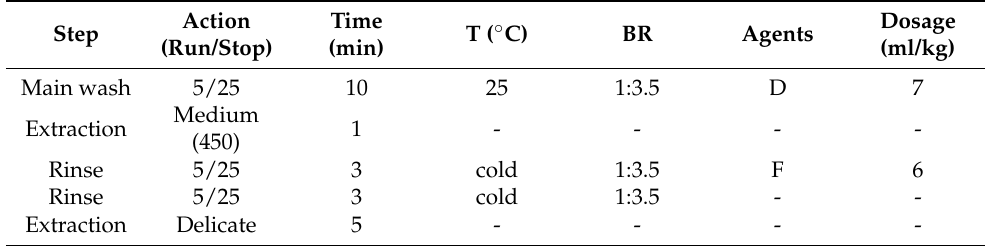
Table 4. Wet cleaning (W*) of PES/CO/SS fabric.